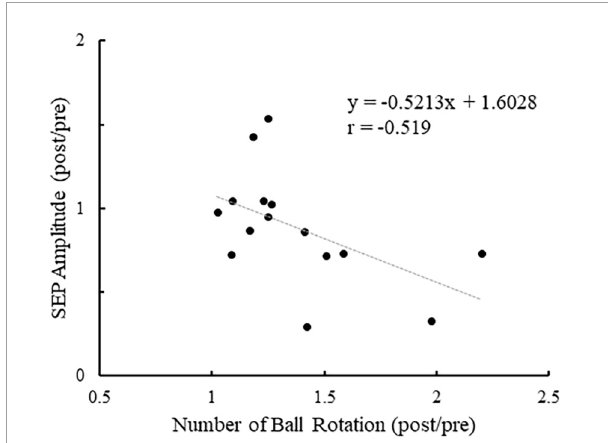
FIGURE7 The plot of the change in the number of ball rotations relative to the change in P45 amplitude at the C3 (cid:48) electrode for all participants. Values of > 1 indicate enhancement from pre to post.